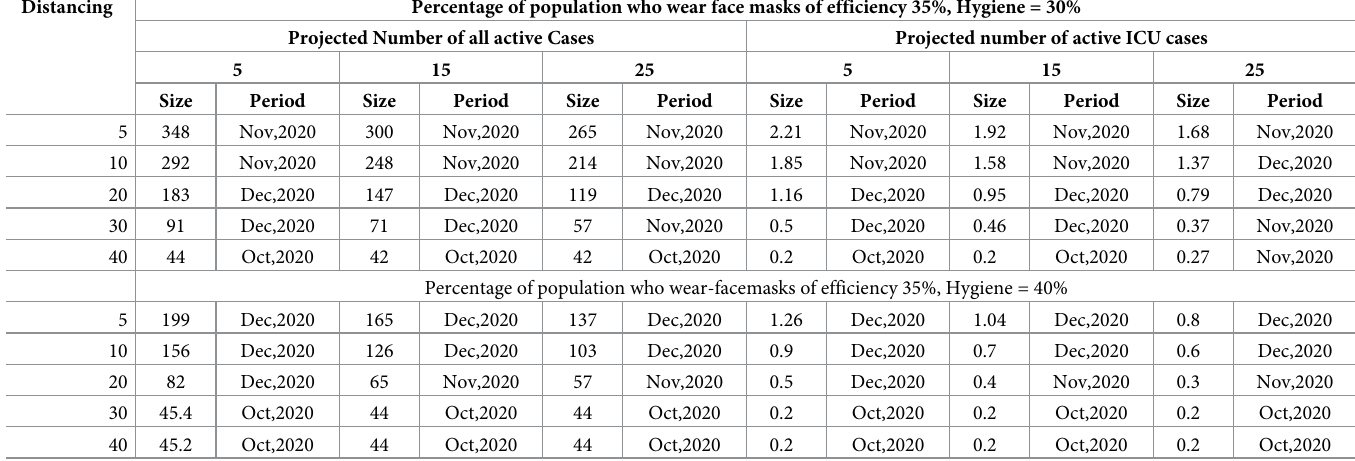
Table 6. Summary of predicted numbers of active COVID-19 and ICU cases (in thousands) under different adherence levels of mask and physical distancing in the urban population of Ethiopia.